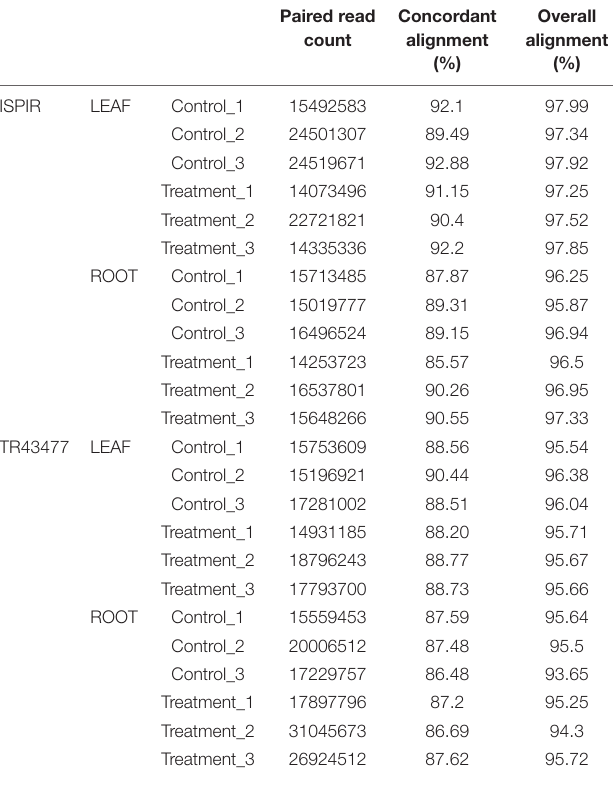
TABLE 3 | Statistics for raw read alignment to refence genome with HISAT2 tool.